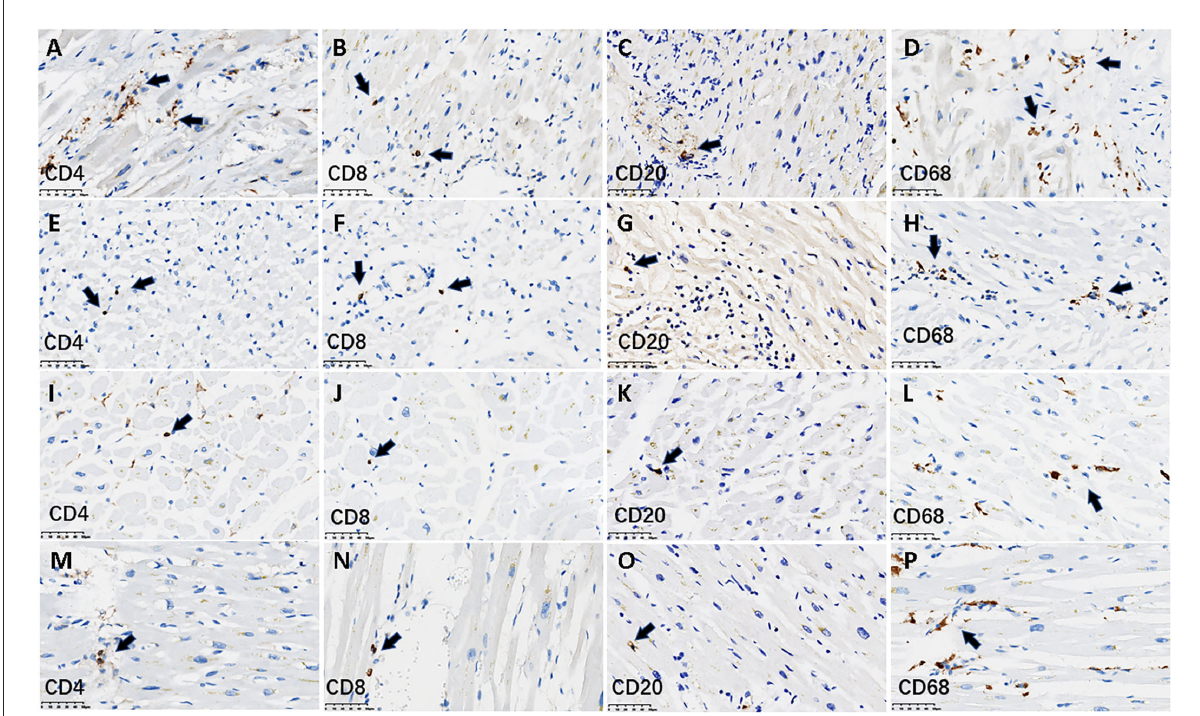
FIGURE2 Lymphocyte infiltration using IHC staining within myocardium in representative cases. The figure shows the infiltration of lymphocytes and macrophages stratified by CD4 + , CD8 + , CD20 + , and CD68 + cells in the myocardium in four cases. (A–H) denote IHC staining for lymphocytes from two cases with neutrophil-infiltrated pathological myocarditis. (A–D) 62-year-old man; (E–H) a 56-year-old woman. (I–P) denote IHC staining for lymphocytes from two cases without pathological myocarditis. (I–L) An 81-year-old man; (M–P) a 59-year-old woman. The immunostaining of two myocarditis cases showed there was a scattered infiltration of very mild CD4 + , CD8 + , CD20 + lymphocytes, and single or small clusters of CD68 + macrophages. This pattern was also seen in the other two cases without myocarditis. The arrows denote the lymphocytes or macrophages. Scale bars represent 50 µ m. IHC,